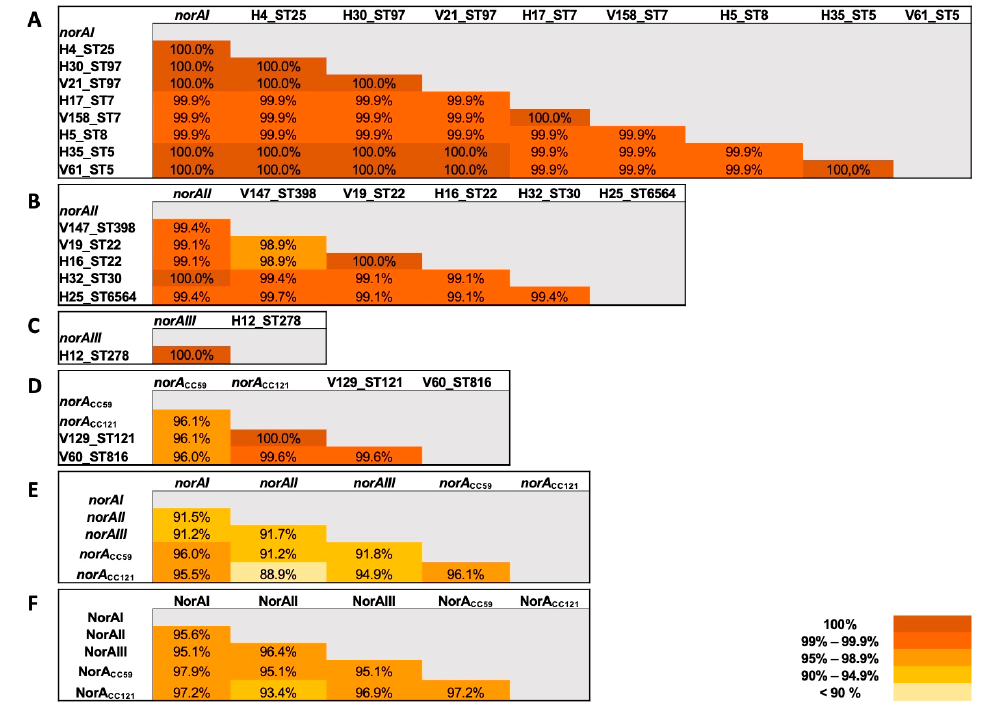
Figure 3. Variability between and within norA alleles ( A – E ) and between NorA proteins ( F ) for the S. aureus strains studied in comparison with prototype alleles and their products. Comparisons were made with MEGA 7.0.26 software and are indicated as the identity between sequences (%). A color code highlights the degree of identity between the compared norA /NorA sequences.